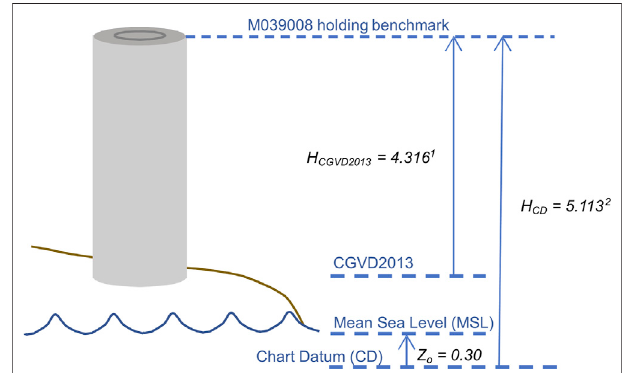
FIGURE3| ThederivationofMeanSeaLevel(MSL)foundinHarperetal. (1988) referenced to CGVD2013 requires consideration of the height of the holdingbenchmarkrelativetothe tide gauge chart datum and the CGVD2013 datum. Values shown are in meters and derived from the following sources: 1 Natural Resources Canada 2021 (Accessed January 22, 2021), 2 Permanent Service for Mean Sea Level (PSMSL) (Accessed January 22,